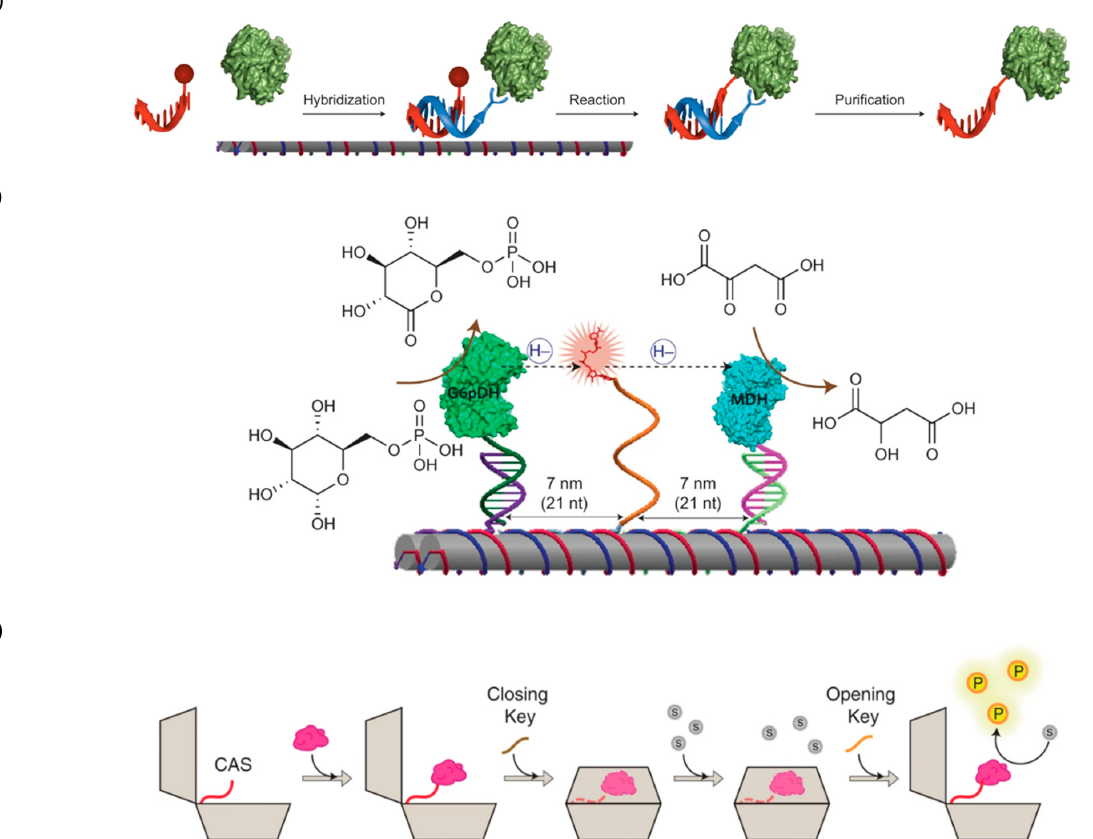
Figure 12. DNA can serve as sophisticated scaffolds for hosting enzymatic reactions. ( A ) Schematic of DNA-templated protein conjugation, in which a guiding strand (blue) hybridizes to the reacting strand (orange) that forms a covalent bond with the protein (green globule). Reprinted from Gothelf and co-workers [138]. ( B ) Tethering of the NADH co-factor on a flexible arm between the enzymes G6pDH and MDH on a DNA scaffold. Reprinted from Yan and co-workers [139]. ( C ) A DNA vault in which an enzyme (pink globule) is targeted within via the cargo-anchoring site (CAS), which can be closed by a “closing key” sequence. Only with the addition of an “opening key” sequence can the enzyme react with the substrate (grey circles) to generate the product (yellow circles). Reprinted from Andersen and co-workers [143]. Copyright ( A , B ) 2014 and ( C ) 2017 Nature Research.